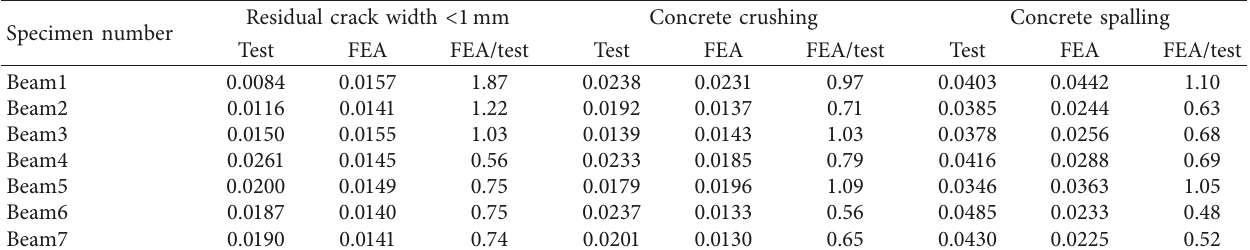
Figure 10: Comparison of experimental and numerical damages. (a) Rebar fracture of specimen Beam1. (b) Concrete spalling of specimen Beam1. Table 5: Comparison of chord rotations of specimens for different concrete damage